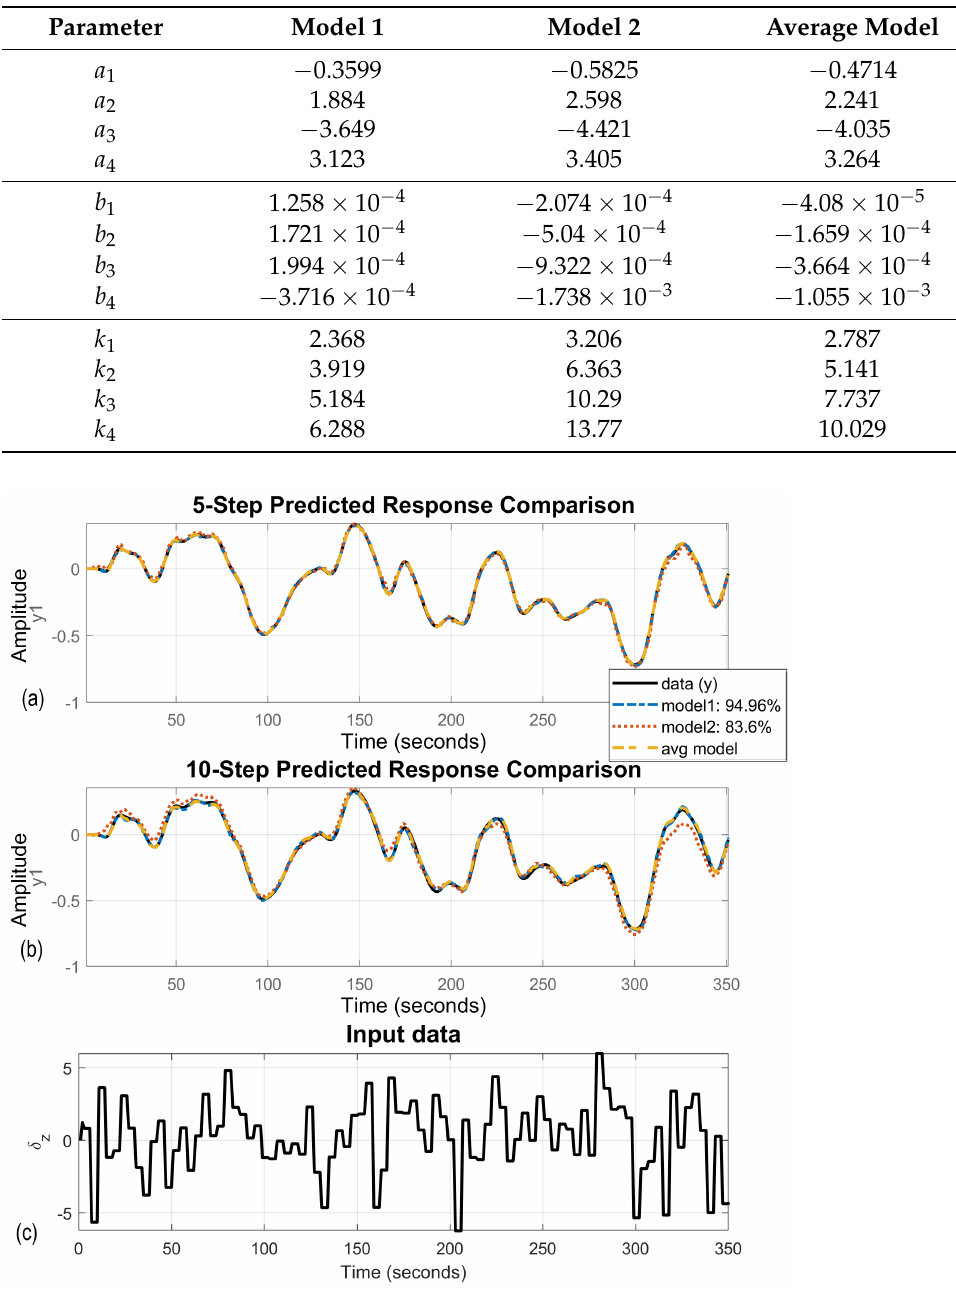
Figure 4. Examples of identified model predictions based on simulated validation data. ( a ) 5-steps ahead prediction, ( b ) 10-steps ahead prediction, ( c ) validation data